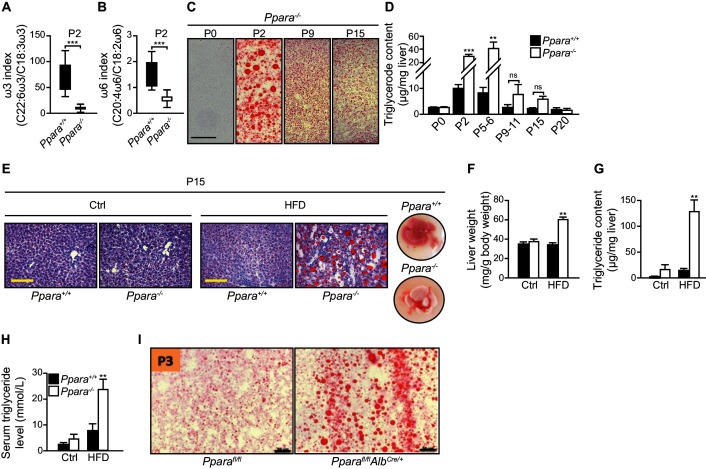
Postnatal lipid catabolic derangements in Ppara-/-pups.(A,B) Boxplots showing the ω-3 (A) and ω-6 (B) indexes of the P2 livers calculated from the ratios of docosahexaenoic acid to α-linolenic acid and arachidonic acid to linoleic acid, respectively. Boxes indicate the 25th to 75th percentiles and whiskers represent the full range; n = 16, ***p<0.001 (two-tailed Mann-Whitney test). (C) Oil Red O staining of cryosections prepared from the PPARα-/- liver at the indicated postnatal days. Note the onset and the progressive recovery of hepatic steatosis in Ppara-/- mice from P2 to P15. (D) Liver triglyceride content measured by gas chromatography-high performance liquid chromatography; n = 4–6, **p<0.01, ***p<0.001 vs. wild-type controls; ns, not significant (two-tailed Mann-Whitney test). (E–H) Ten-day high-fat weaning challenge in 5-day-old Ppara+/+and Ppara-/-pups. Representative images of the Oil Red O-stained liver sections after counterstaining with methylene blue are shown (E). Right-most panel shows the dissected livers at P15 after the challenge. Note the pallid color of Ppara-/-liver. Scale bars = 100 μm. Wet liver weight (F), liver triglyceride levels (G), and serum triglyceride levels (H) measured in P15 pups fed the control (Ctrl) or high-fat diet (HFD). (I) Oil Red O staining of cryosections prepared from the liver of hepatocyte-specific knockout of PPARα (Pparafl/flAlbCre/+) and control (Pparafl/fl) pups at postnatal day three (P3). Scale bars = 100 μm. Bars represent means ± SEM; n = 4–6, **p<0.01 vs. wild-type controls under the same dietary treatment (two-way ANOVA with Bonferroni post-hoc analysis).